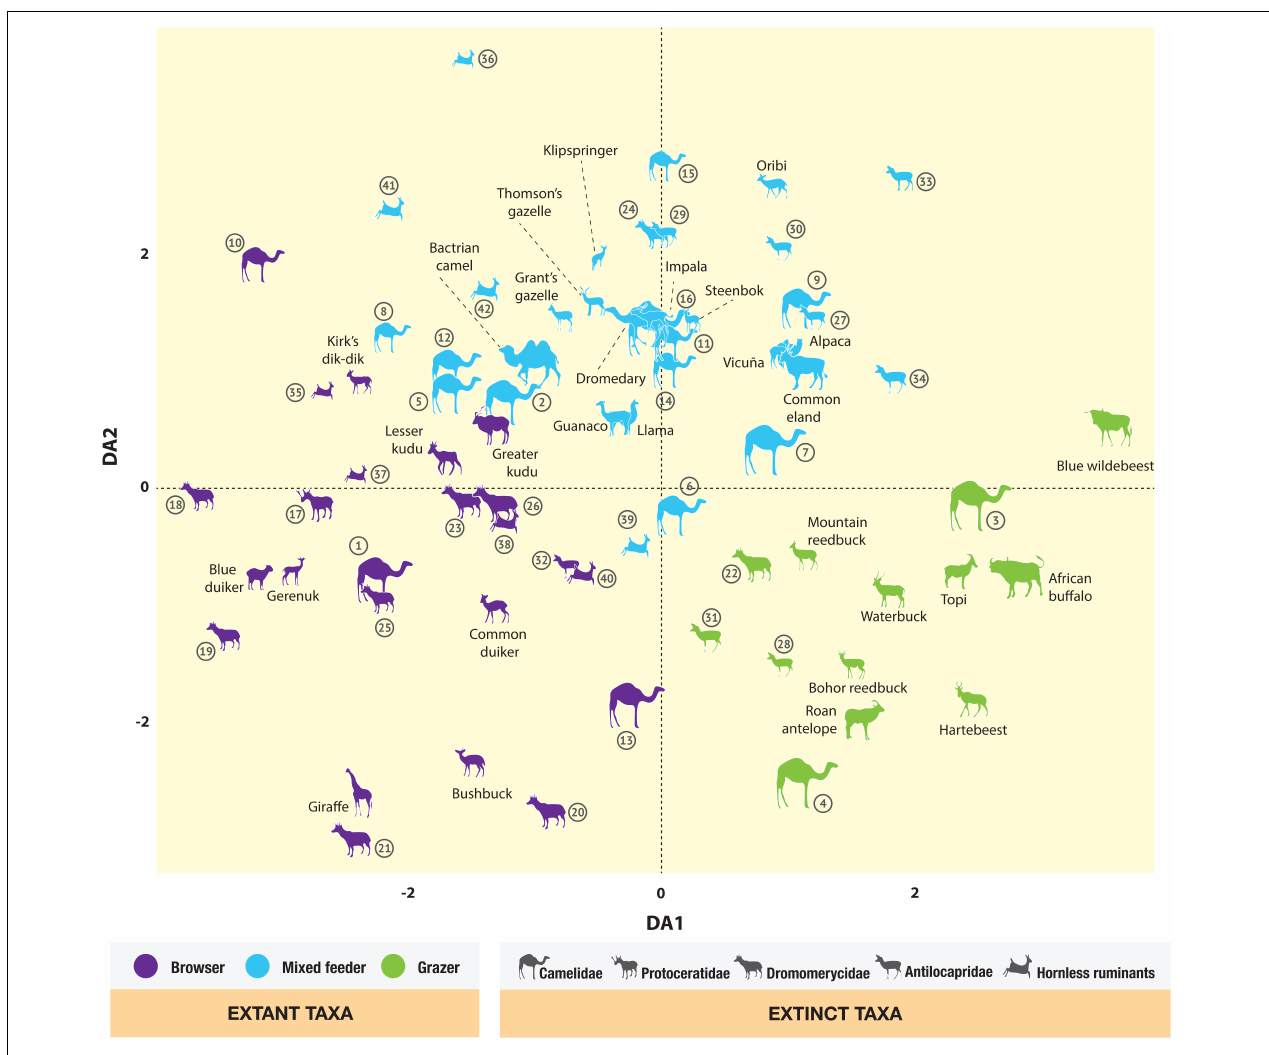
FIGURE 5 | Phylogenetic flexible discriminant analysis results, showing Discriminant Axis one (DA1) and two (DA2). Extinct taxa are color coded based on their posterior probability of belonging to one of the established dietary categories (see Appendix 10). Taxa numbers as in Figure 4 .